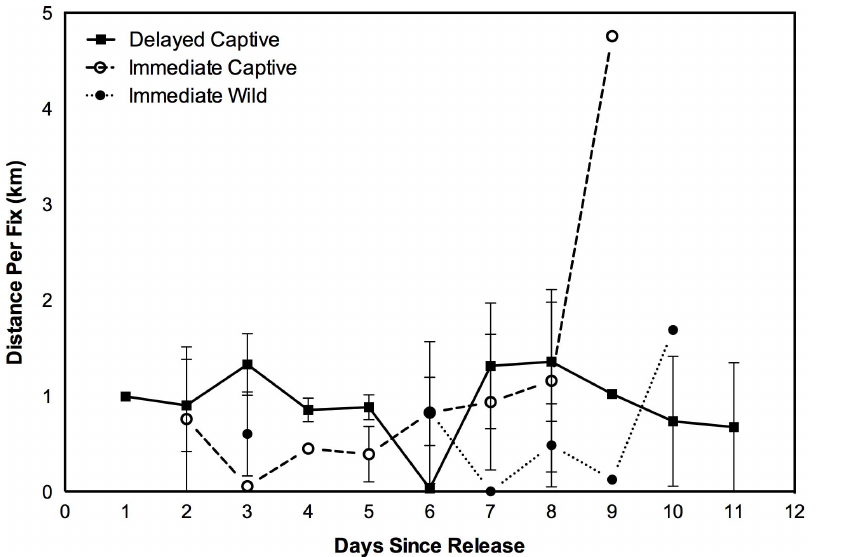
Figure 4. Average distances moved between radiotracking fixes for delayed and immediate release greater bilbies after release into the Northern Paddock. For delayed release animals, time since release refers to when the containment pen was opened and animals allowed access to the Northern Paddock. Bars denote 1 standard error, points without bars are single individuals.